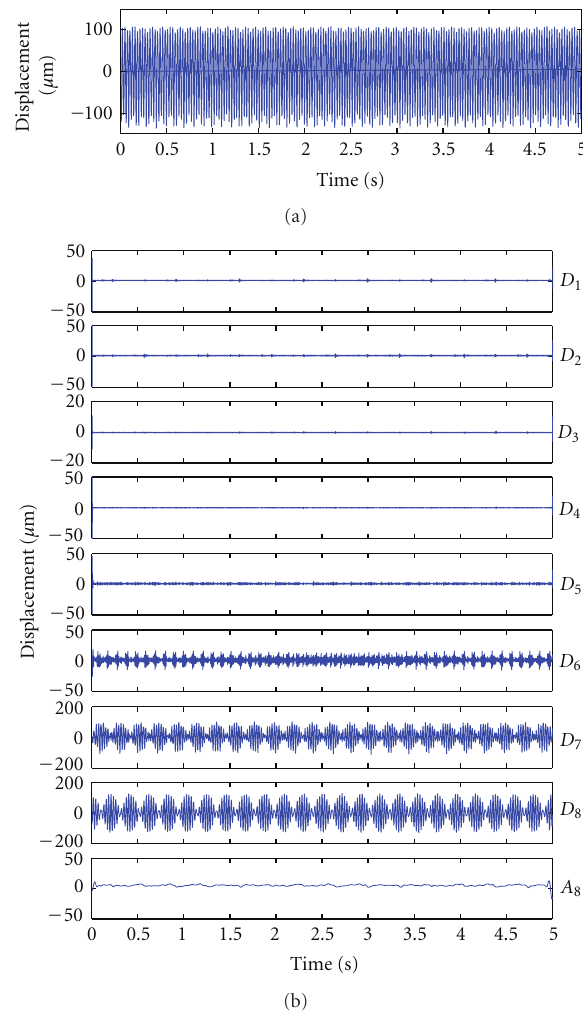
Figure 6: Time series plot (a) and multiresolution decomposition (b) of the vibration signal for healthy rotor with excitation.